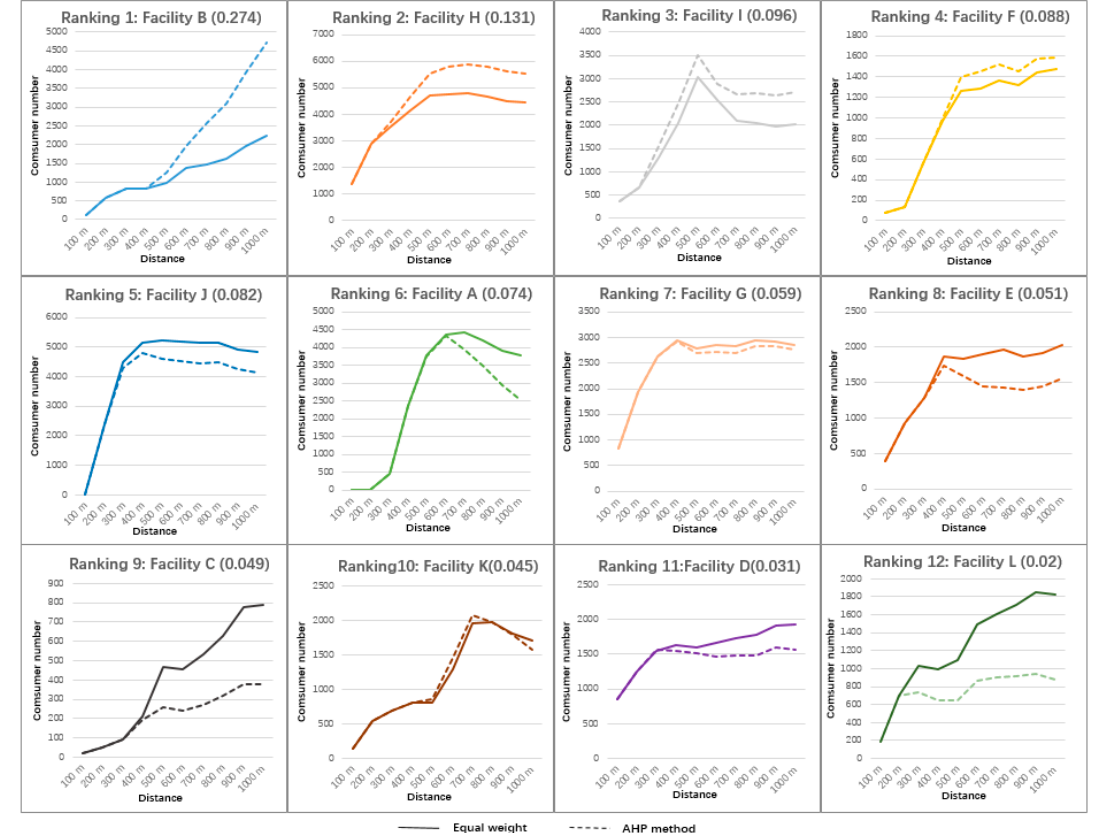
Figure 11. Sensitivity of consumer numbers by two types of facility attractiveness with a varied rang e.